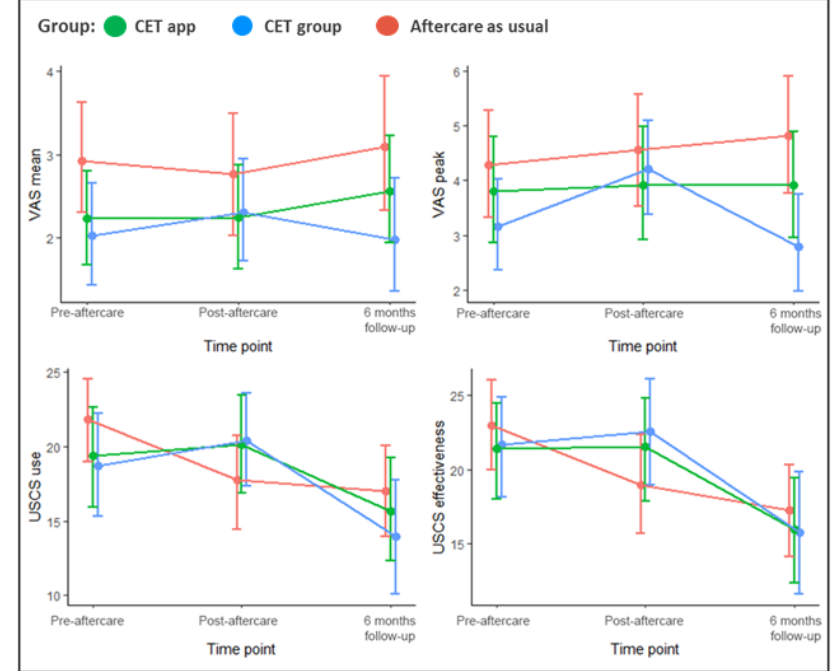
Figure 3. Secondary outcomes by group allocation over time among individuals receiving cue exposure therapy (CET) as group aftercare or as a mobile phone app, or aftercare as usual. USCS: urge-specific coping skills (a lower score reflects less use or lower perceived effectiveness); VAS: visual analog scale (a lower score reflects fewer alcohol